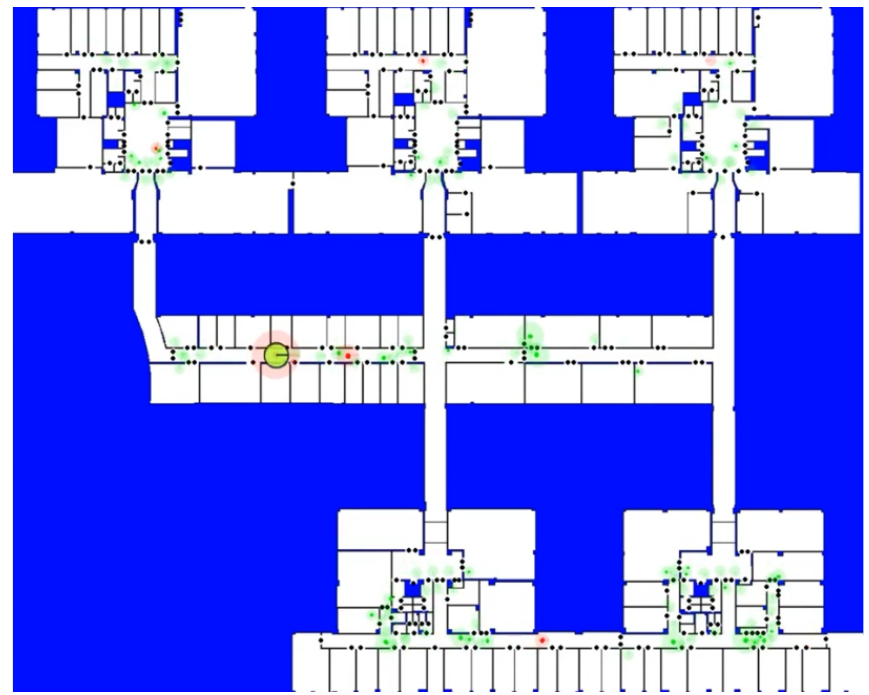
Figure 2. At the screenshot the building map where the different tests were developed. Black dots represent doors on the map. Circles represent the clusters and their size is related to their accumulated probability. Cluster color: green corresponds to the short-term (ST) filter and red represents the long-term LT) filter. As it can be seen, the largest red cluster corresponds to final estimation of the robot